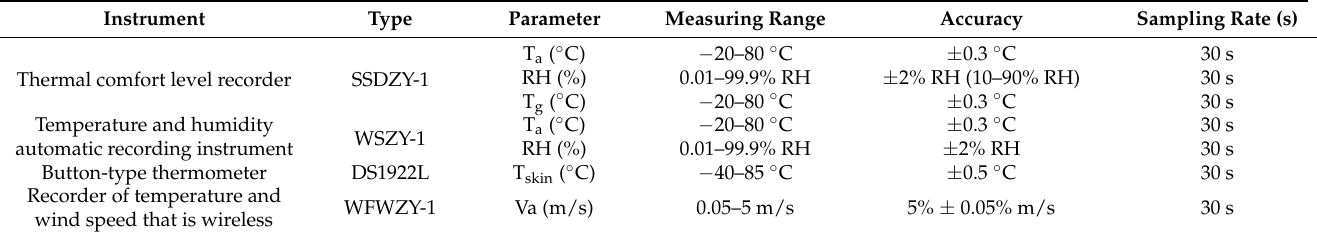
Table 4. Measurement devices and